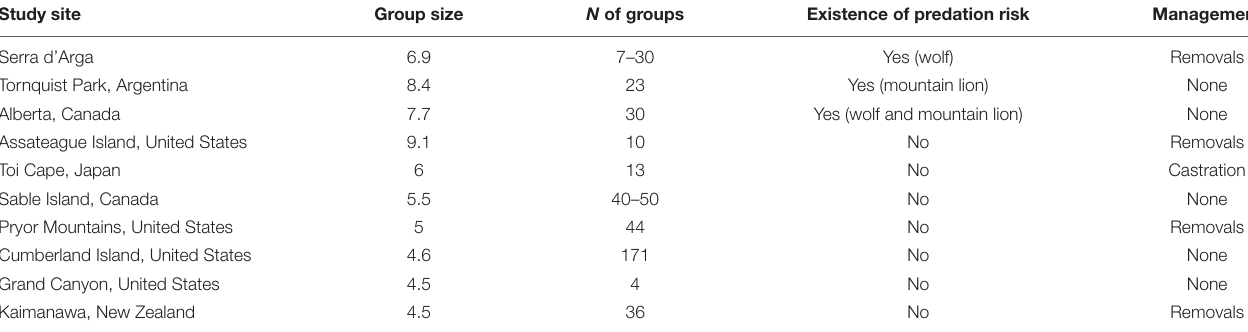
TABLE 8 | Average group size (including foals) and number of males in mixed-sex groups in SA and at other feral horse study sites. Study